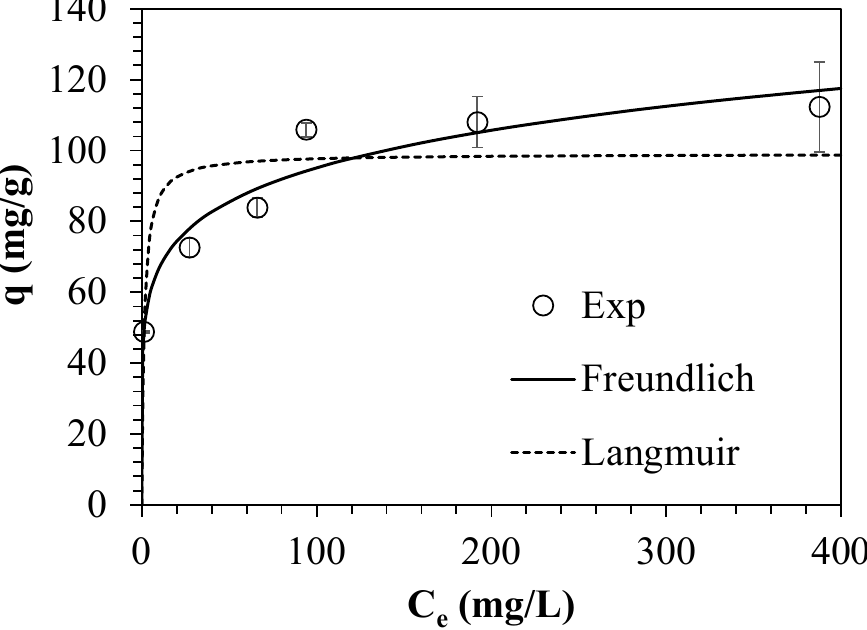
Figure 5. Adsorption isotherms of Cu(II) ions onto surface-modified PAN fibers. Here, q and C e denote the adsorption capacity and Cu(II) equilibrium concentration, respectively. Table 2. Parameters of Langmuir and Freundlich models for adsorption of Cu(II) on surface-modified PAN fibers. Here, K L , K F , q m , n, and R 2 denote the Langmuir and Freundlich equilibrium adsorption constants, maximum sorption capacity of metal ions on adsorbent, Freundlich constant, and determination coefficient, respectively.